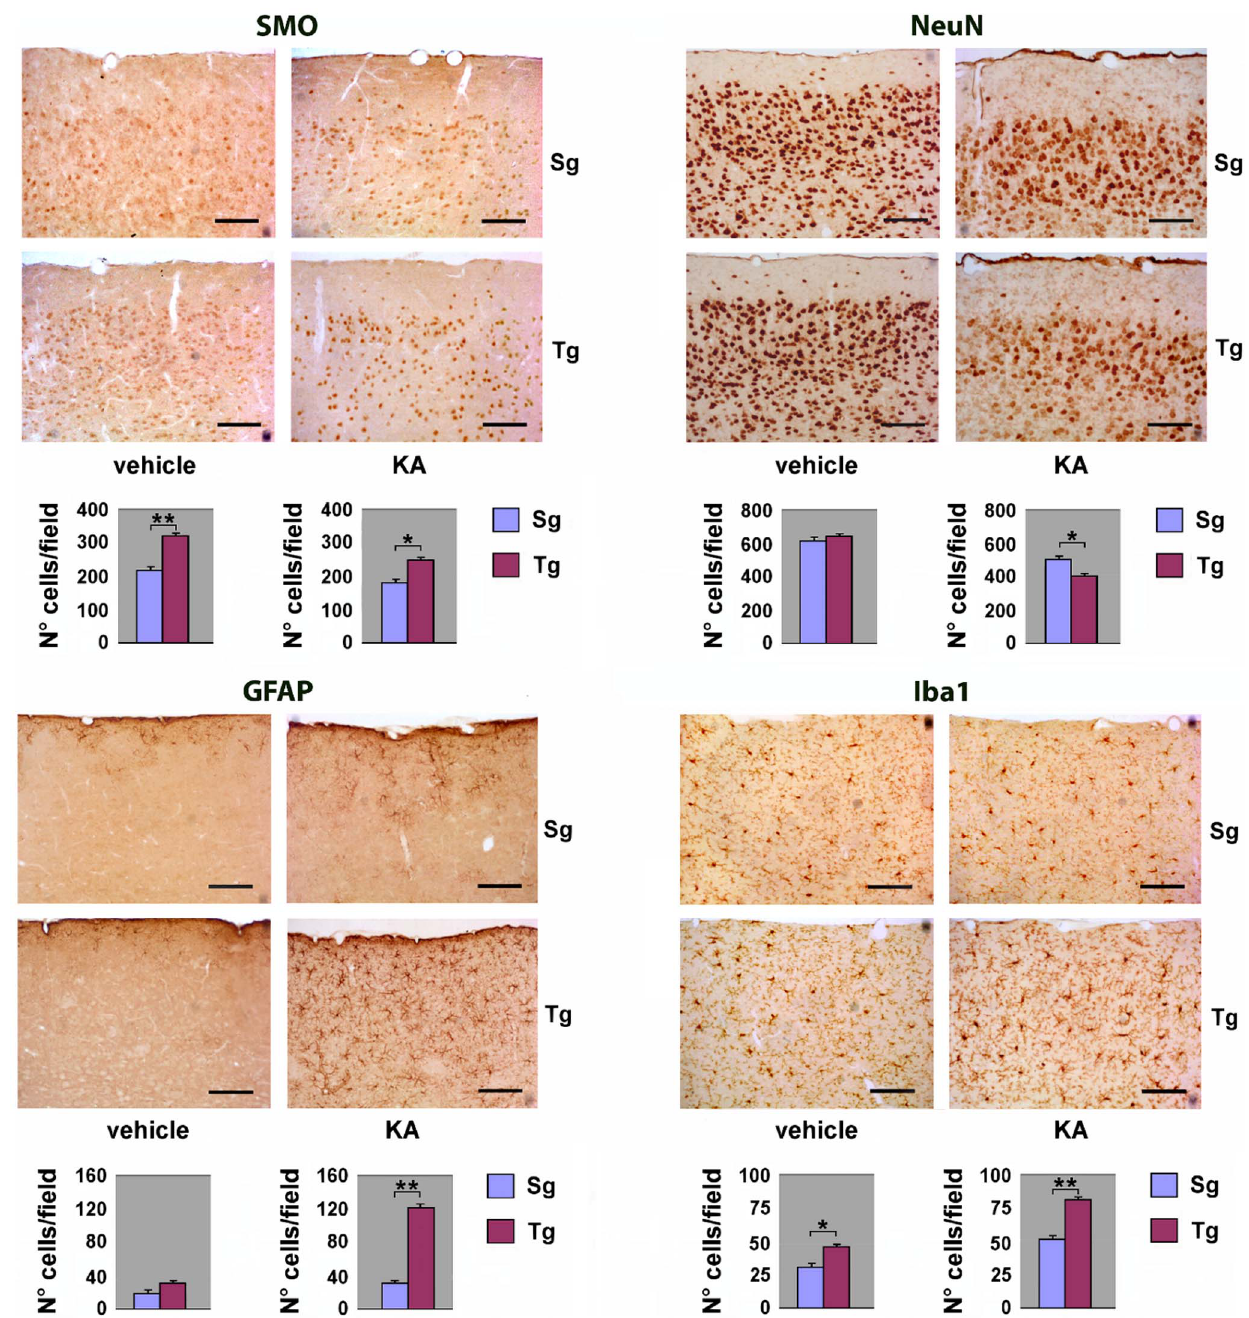
Figure 7. Immunohystochemical analysis of neocortex from KA treated Tg and Sg mice. Sagittal brain slices from JoSMOrec mice were stained with antibodies directed against SMO, NeuN, GFAP and Iba1. Slides of neocortex from KA treated 3 months old mice were analyzed. Cell counting is expressed as number of positive cells per 0.24 mm 2 area. The p values were measured with the two-way ANOVA test and post-hoc test Bonferroni (*, p , 0.05; **, p , 0.01). Sg, syngenic mice; Tg, transgenic mice. from non-transgenic littermates (WT) using antibodies directed in agreement with the higher Spd and Put content in the against SMO, NeuN, GFAP and Iba1. No different expression of neocortex showed by young Tg mice. The immunohistochemical the markers analyzed was observed between WT and Sg mice. analysis of neocortex in JoSMOrec mice using GFAP and Iba1 This indicates that SMO overexpression is affecting Tg phenotype, markers showed a significant astroglial and microglial activation in leading to a more pronounced brain damage during ageing, old Tg mice. In order to rule out any hypothetical side-effects due possibly due to a SMO-derived overproduction of H 2 O 2 when to random transgene integration and consequently gene disrup- tion, we performed immunohystochemical analyses of neocortex cellular antioxidant defences become less efficient in old mice. In